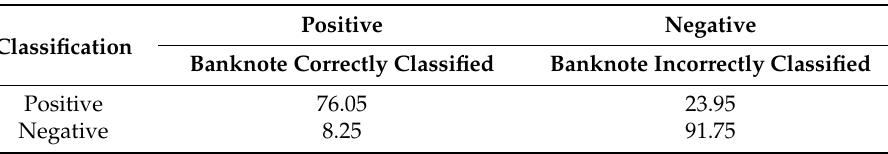
Figure 9. Banknote detection examples: white rectangle is generated around the banknote once it is detected. ( a ) Banknote detection from a surface; ( b ) Banknote detection on the human hand. Table 1. Banknote detection matrix of confusion, %.